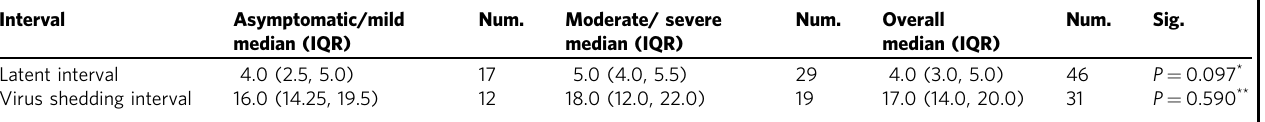
Table 1 Latent interval and virus shedding interval of the Delta infections. Interval Asymptomatic/mild median (IQR)